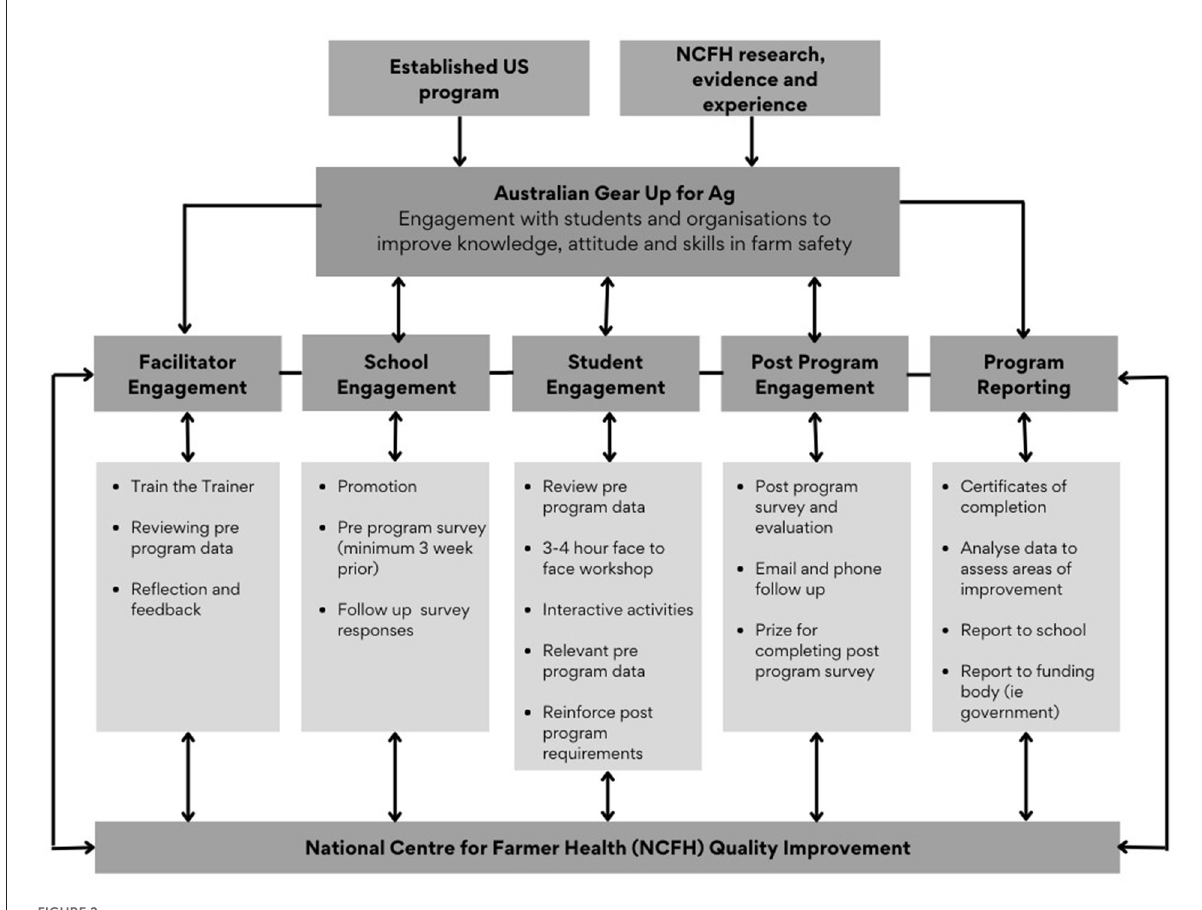
FIGURE2 Method and process for delivering a Gear Up for Ag TM education